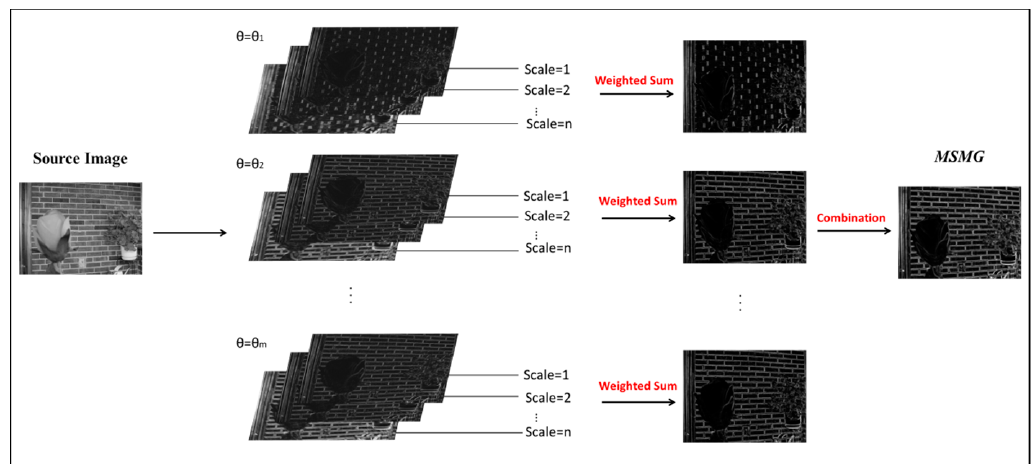
Figure 3. Demonstration of constructing the multi-scale morphological gradient.